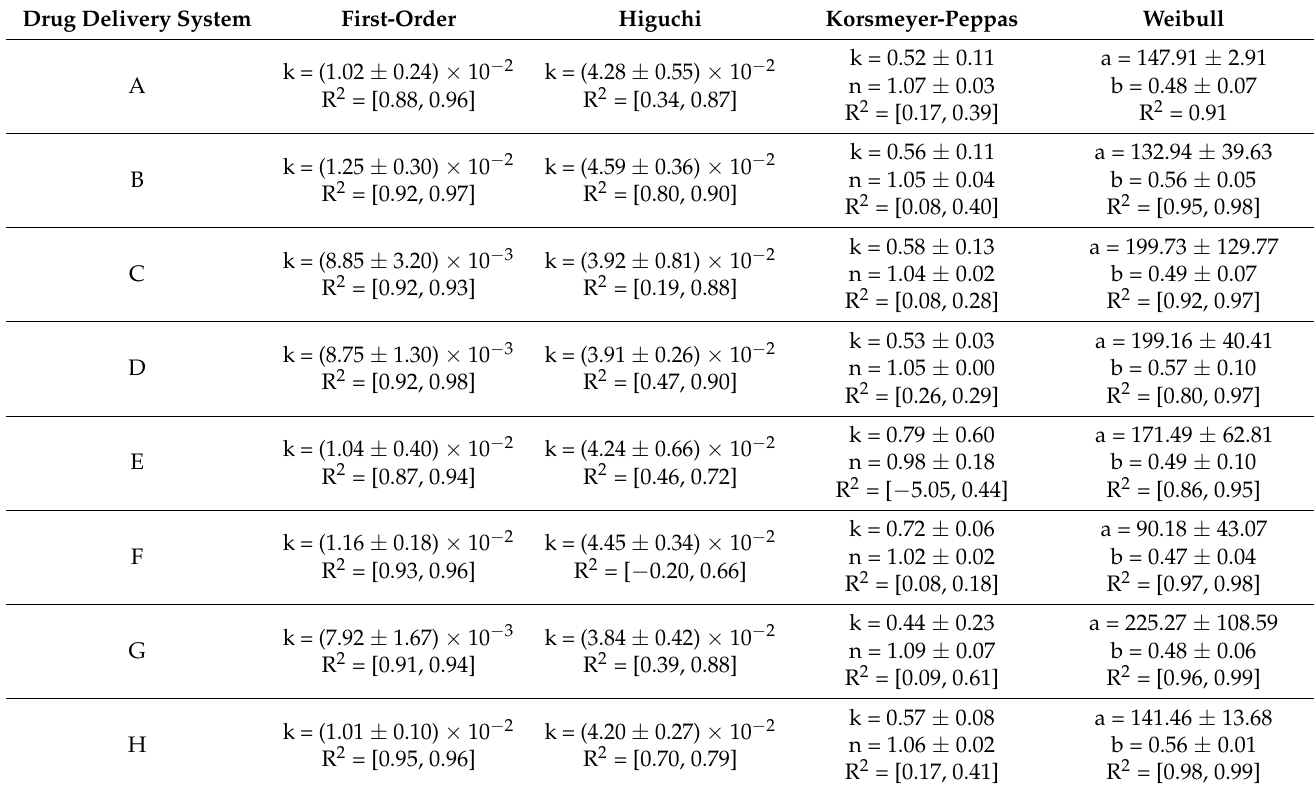
Table 2. Summary of kinetic parameters for flurbiprofen release from polymer